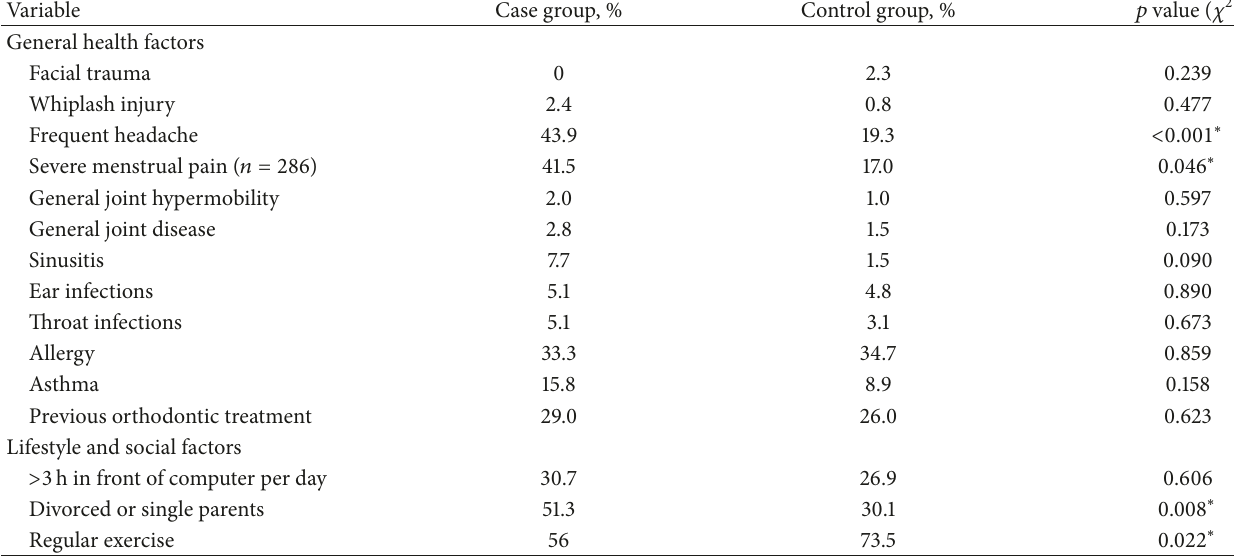
Table 1: The frequency of different variables in the case group (TMD-P) versus control group.